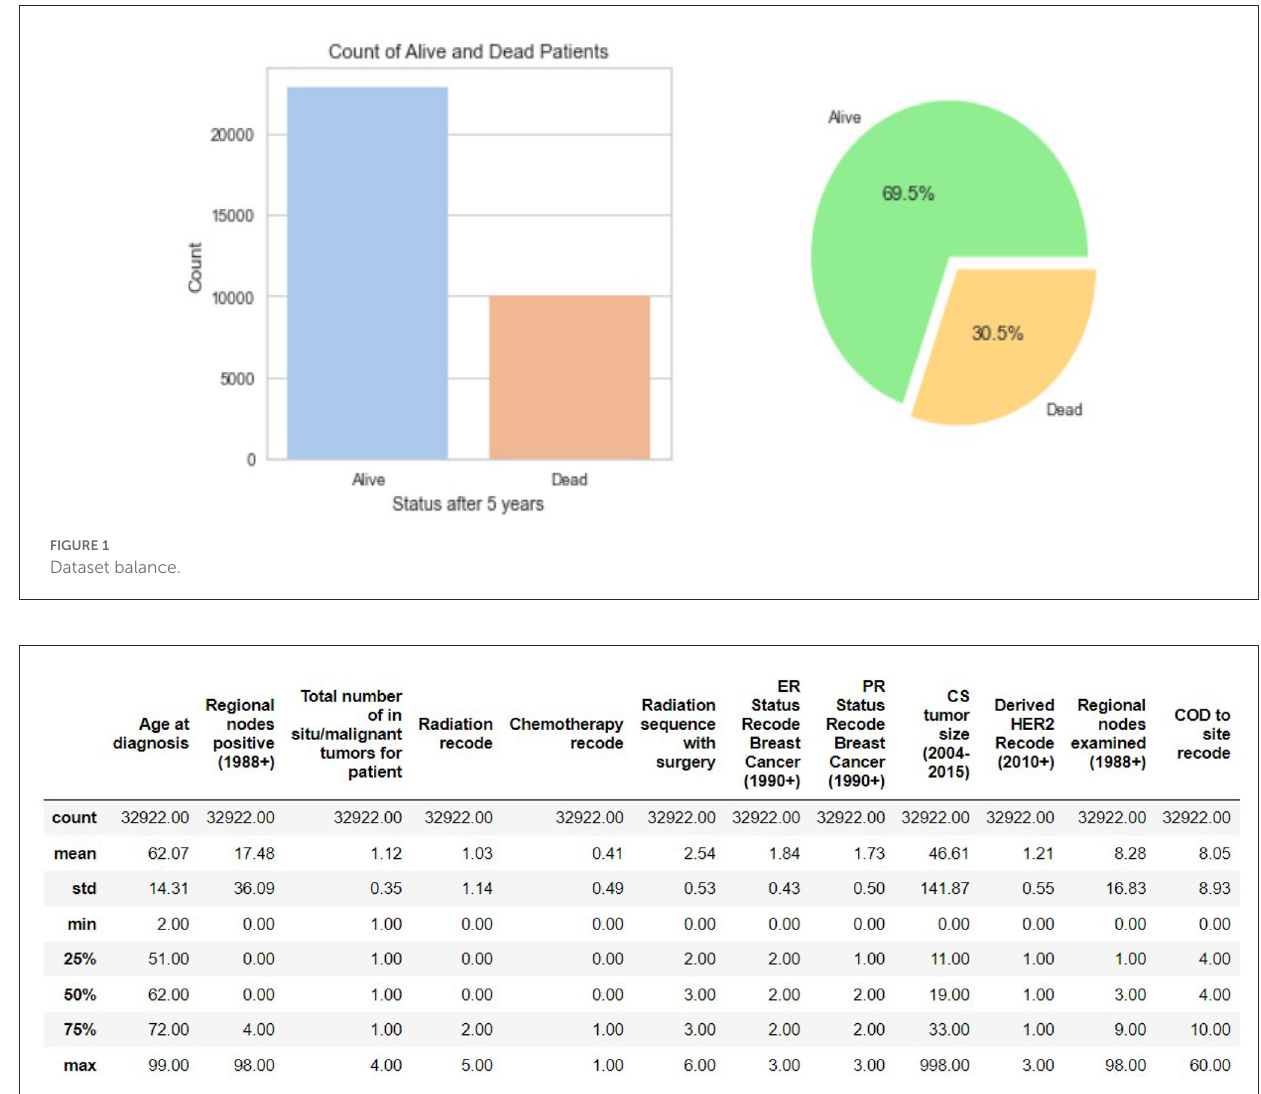
FIGURE2 Dataset